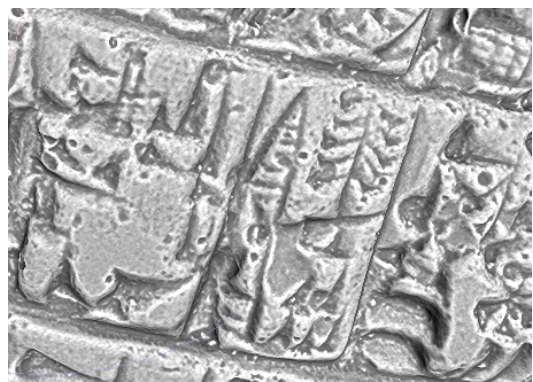
Figure 7: Small detail of the laser scanner 3D model of the tablet from Ebla